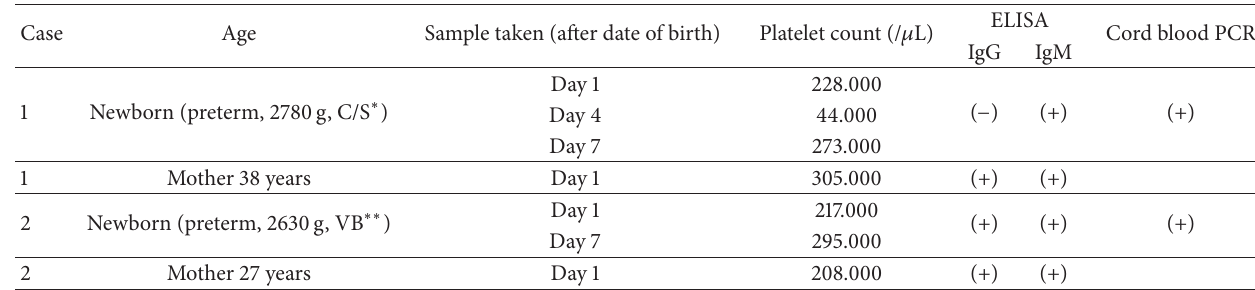
Table 1: Laboratory findings of mothers and